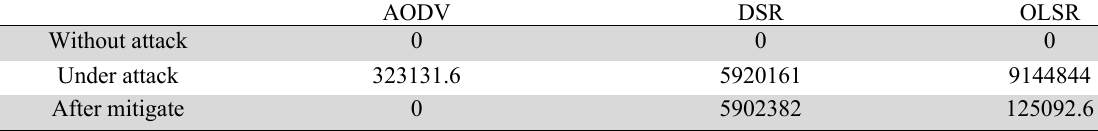
Packet Loss/Drop Packet for each protocol in different scenarios AODV DSR Without attack 0 Under attack After